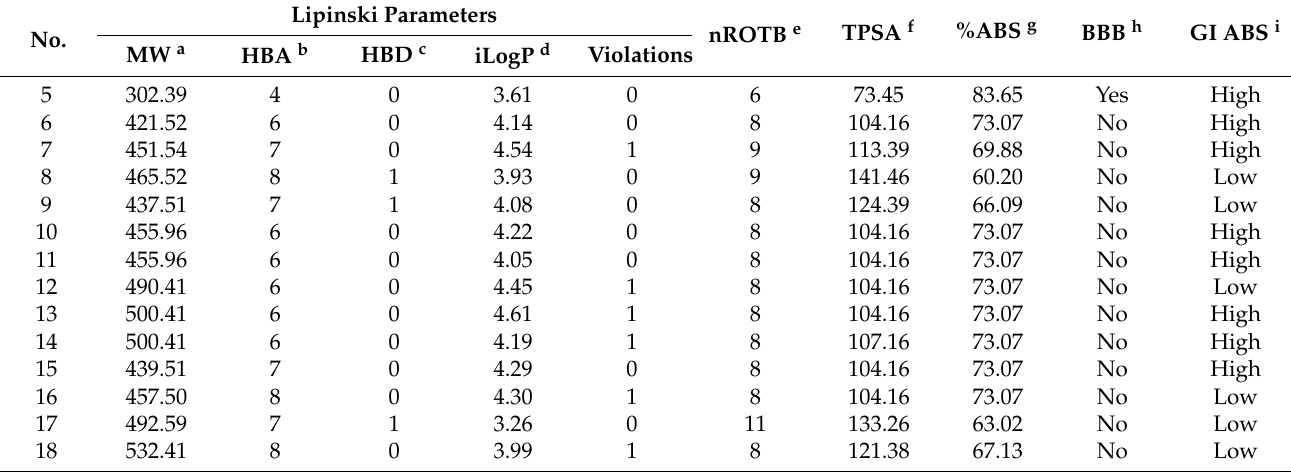
Table 1. Absorption, distribution, metabolism, and elimination (ADME)/Pharmacokinetics studies of final hybrids 5 – 18. Lipinski No.